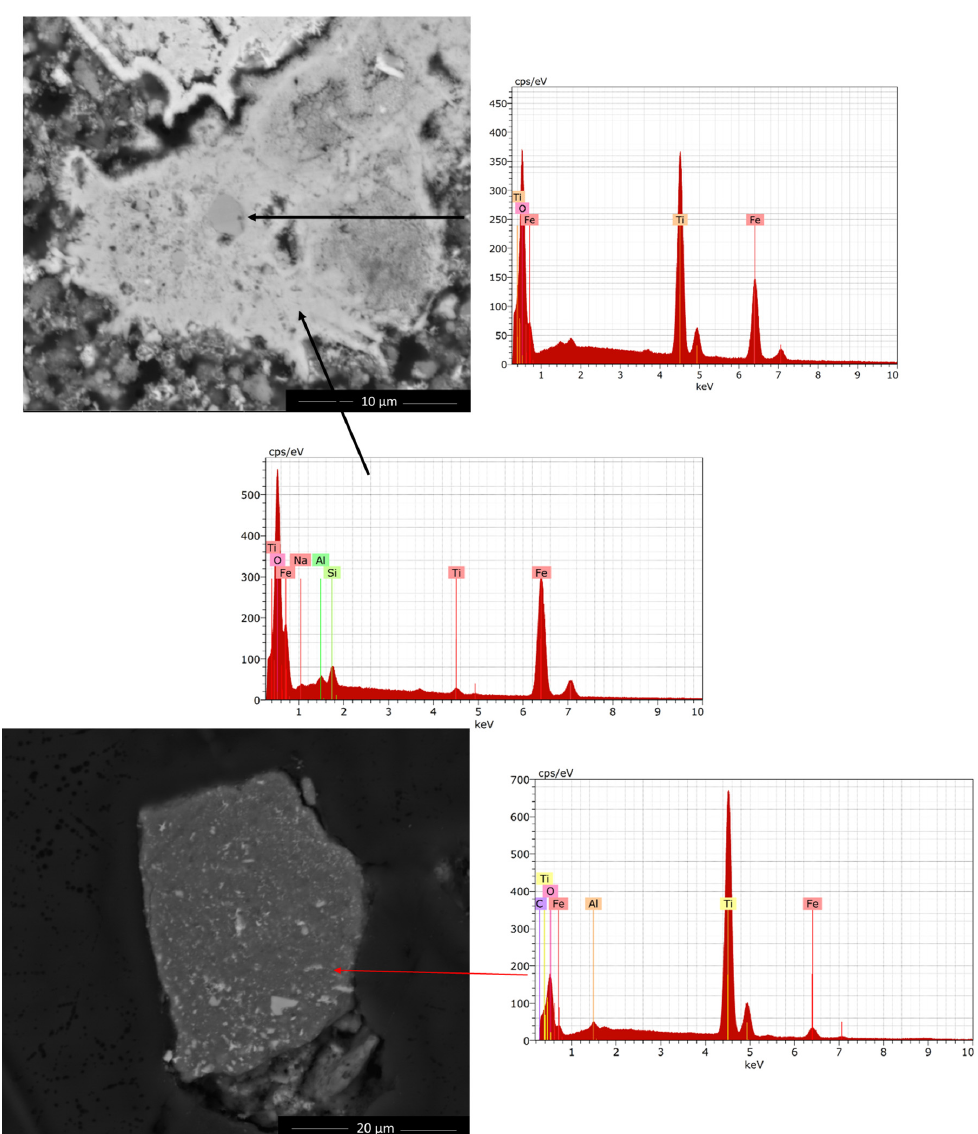
Figure 6. Scanning electron microscope (SEM) micrographs of red mud (above) and H 2 SO 4 leach residue (below).